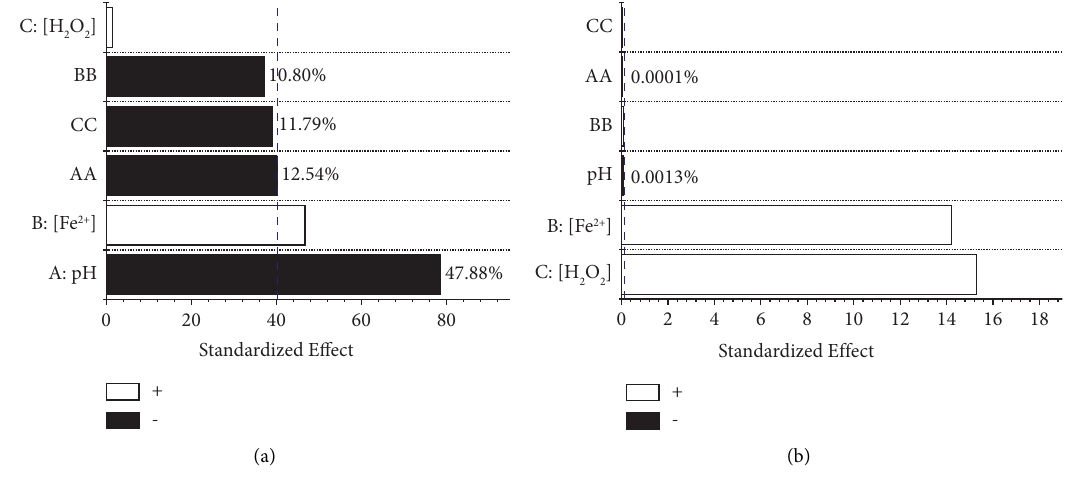
Figure 4: Pareto diagrams for (a) %R